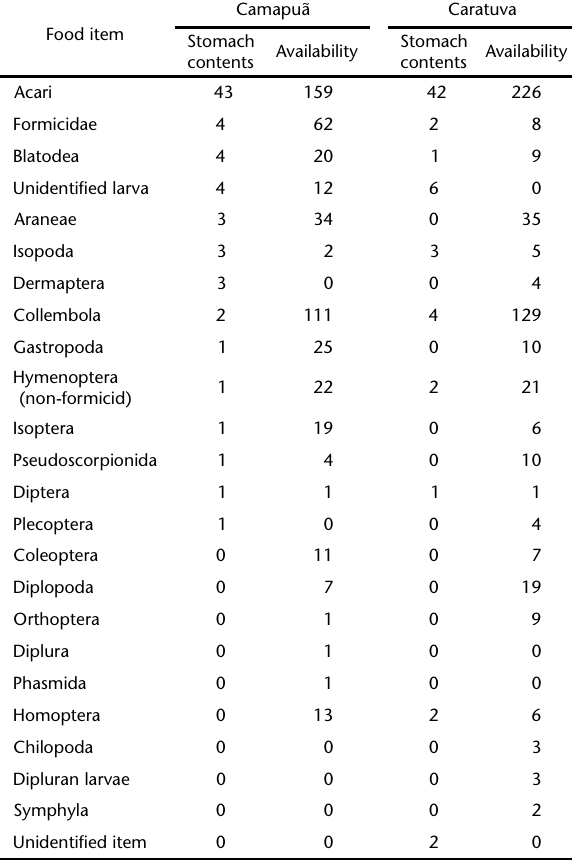
Table I. Dietary items found in the stomach contents of 20 Bracycephalus brunneus individuals collected in the Pico Camapuã and Pico Caratuva, municipality of Campina Grande do Sul, Paraná, Brazil, as well as the availability of food items in the